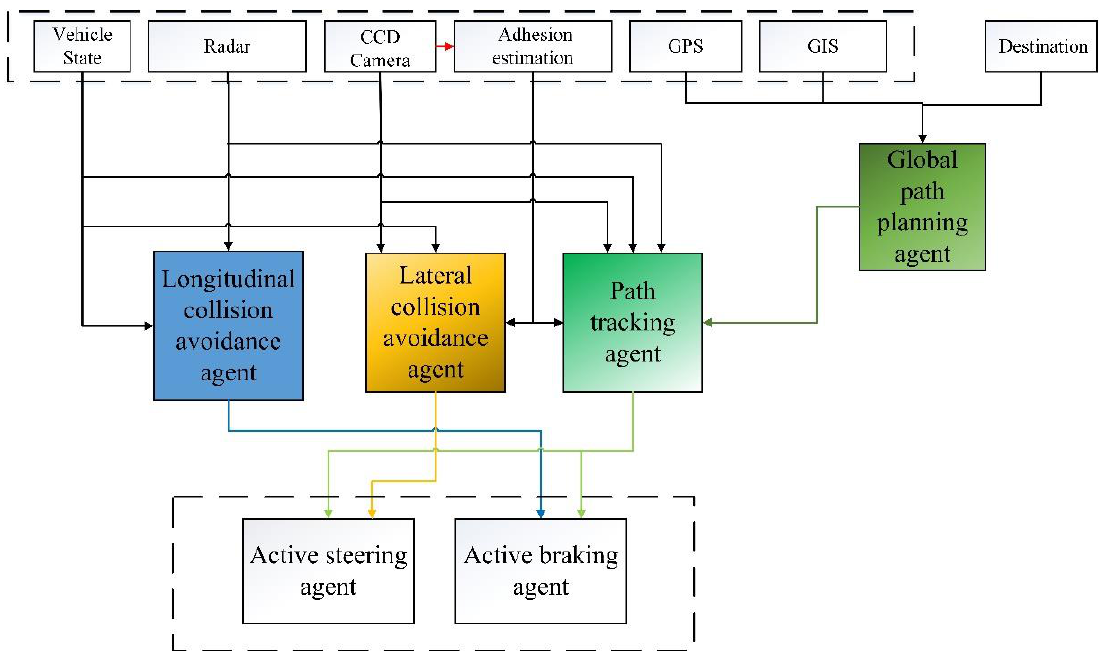
Figure 3. Topology of multi-agent coordinated control system.